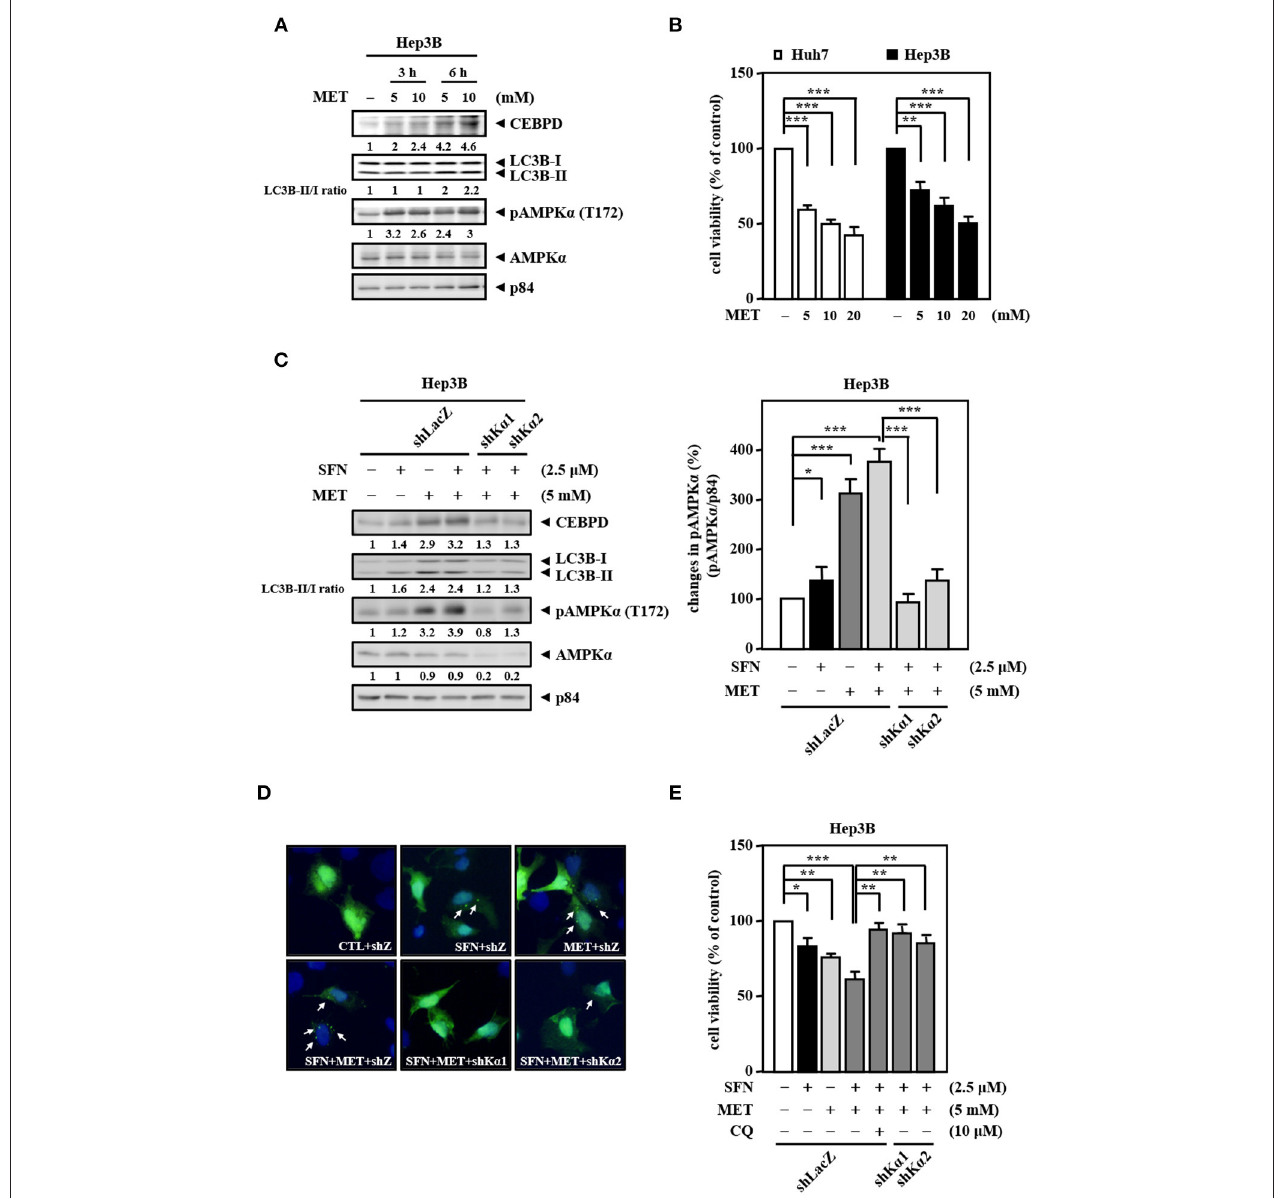
FIGURE 5 | Metformin improves the sensitivity of Hep3B cells to sorafenib. (A) Hep3B cells were treated with metformin at the indicated concentrations for 3 and 6h. Whole cell lysates were harvested for Western blot analyses. (B) Huh7 and Hep3B cells were treated with metformin (MET) at the indicated concentrations for 48h. The cell viability of the experimental cells was measured by MTT assays after 48h of metformin treatment at the indicated concentrations. (C) Hep3B cells were infected with lentiviruses encoding shLacZ (shZ) or shAMPK α (shK α 1 or shK α 2) for 3 days. Hep3B cells were treated with sorafenib (2.5 µ M) or metformin (5mM) alone or with the combination of sorafenib (2.5 µ M) and metformin (5mM) for 24h. Whole cell lysates were harvested for Western blot analyses. The quantitative analysis of phosphorylated AMPK was shown in the graph. (D) Hep3B cells were transfected with GFP-LC3B expression vectors and then treated with sorafenib or metformin alone or with the combination of sorafenib and metformin for 6h. The number of LC3B puncta was evaluated under a fluorescence microscope. (E) Hep3B cells were pretreated with or without chloroquine (CQ, 10 µ M) for 30min and then treated with sorafenib or metformin alone or with the combination of sorafenib and metformin for 48h. The cell viability of the experimental cells was measured by MTT assays. The data are shown as the mean ± SD. * P < 0.05; ** P < 0.01; *** P < 0.001 by Student’s t -test.